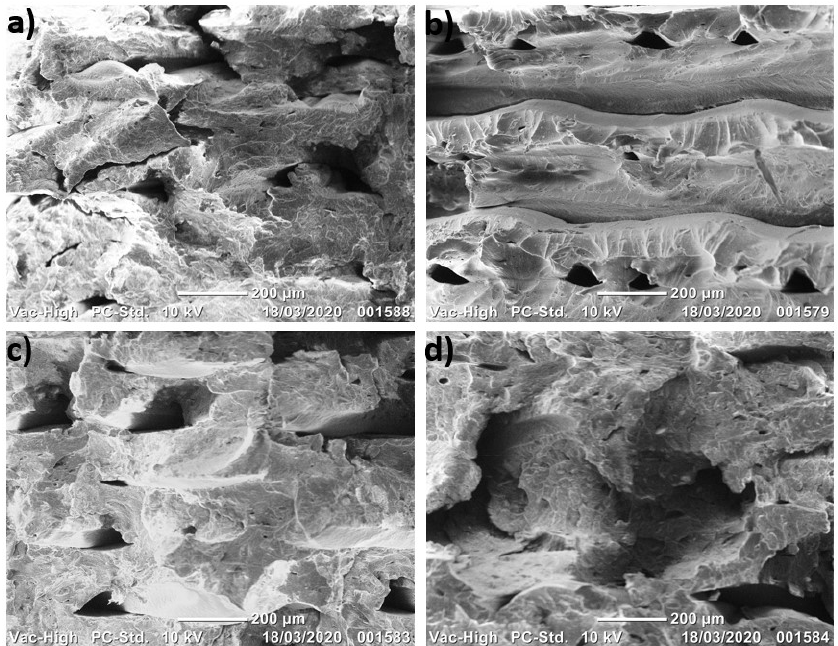
Figure 16. SEM micrographs for Al-ASA material: ( a ) control Al-ASA; ( b ) annealed at 70 °C; ( c ) annealed at 80 °C; ( d ) annealed at 90 °C.